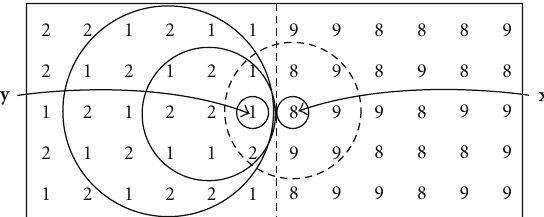
Figure 5: The S − 1 ( x ) set of spheres that contain pixel x , adjacent to the boundary between two noiseless regions (same as Figure 2) with respective intensities of 1 and 9.